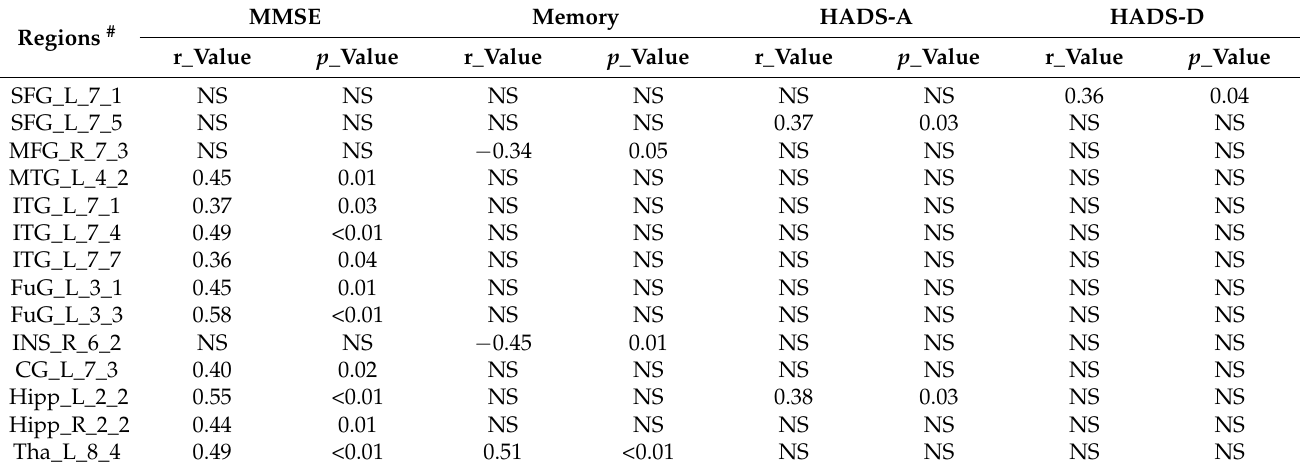
Table 3. Significant correlations between the GM volumes and clinical parameters in TBI patients.